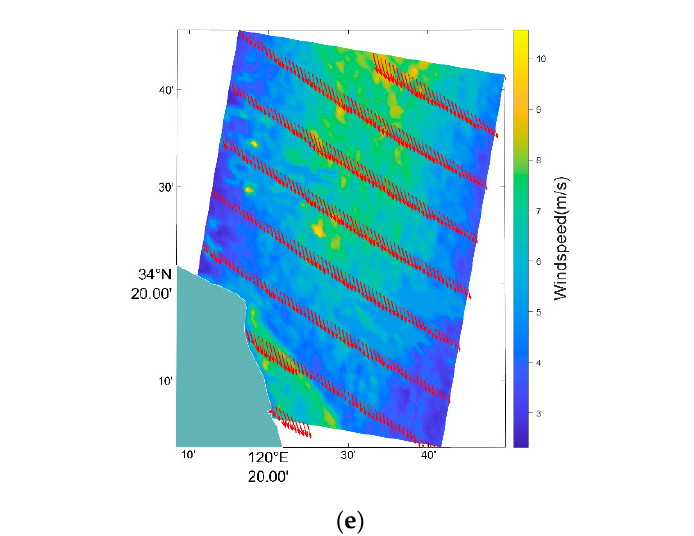
Figure 3. The input wind field of the five scenes. ( a – e ) are the wind fields in red square area of Figure 1.